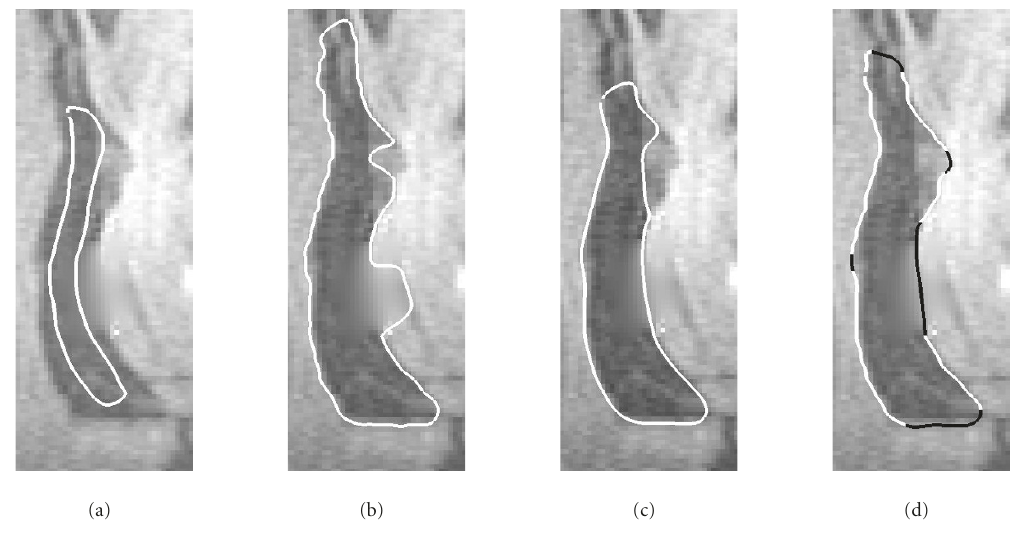
Figure 14: Constant and local regularization on an MRI image. (a) Initial snake and original MRI image. (b) Final segmentation after 310 iterations using λ = 1. (c) Final segmentation after 250 iterations using λ = 300. (d) Final segmentation after 330 iterations using local λ values (black for λ = 300, white for λ =